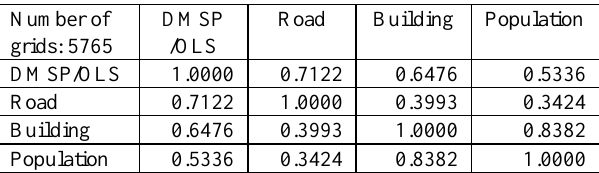
Table 5. Correlation table in suburban area of Tohoku region